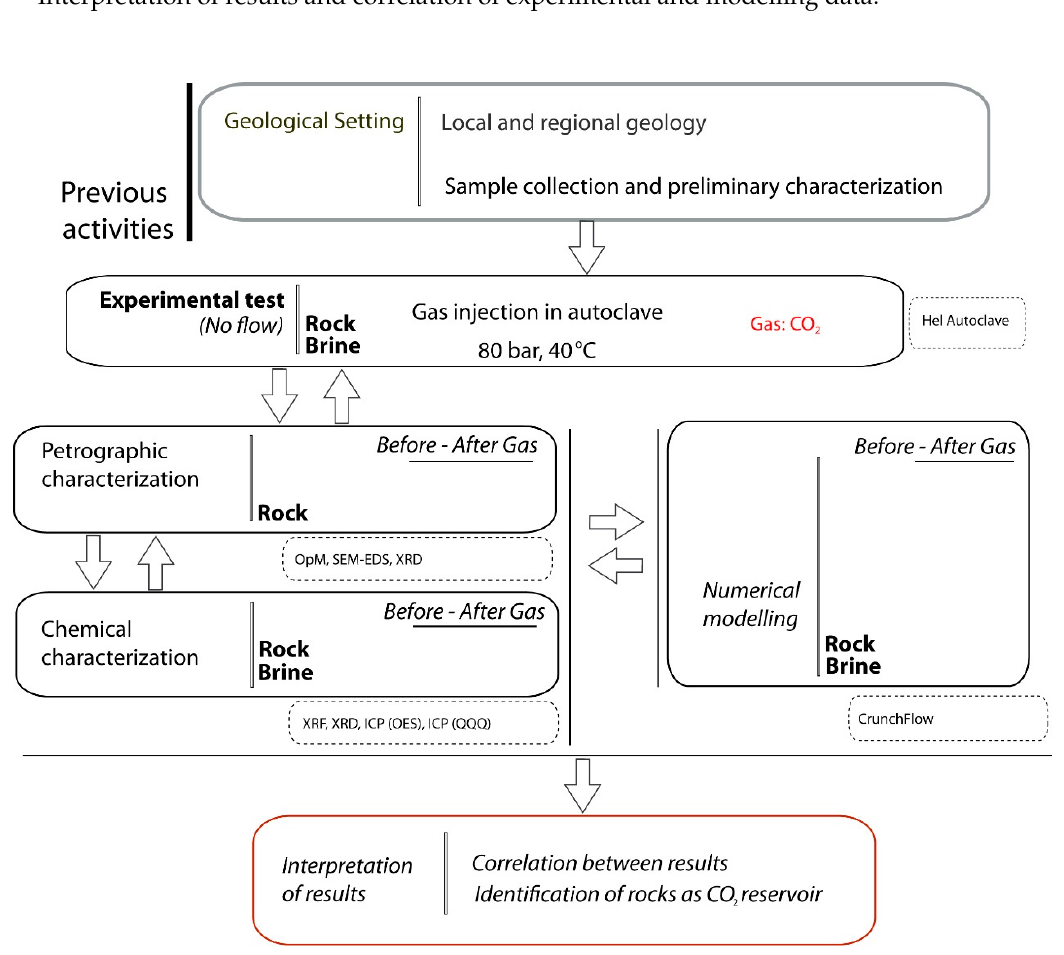
Figure 1. Schematic representation of the work sequence followed in this study.